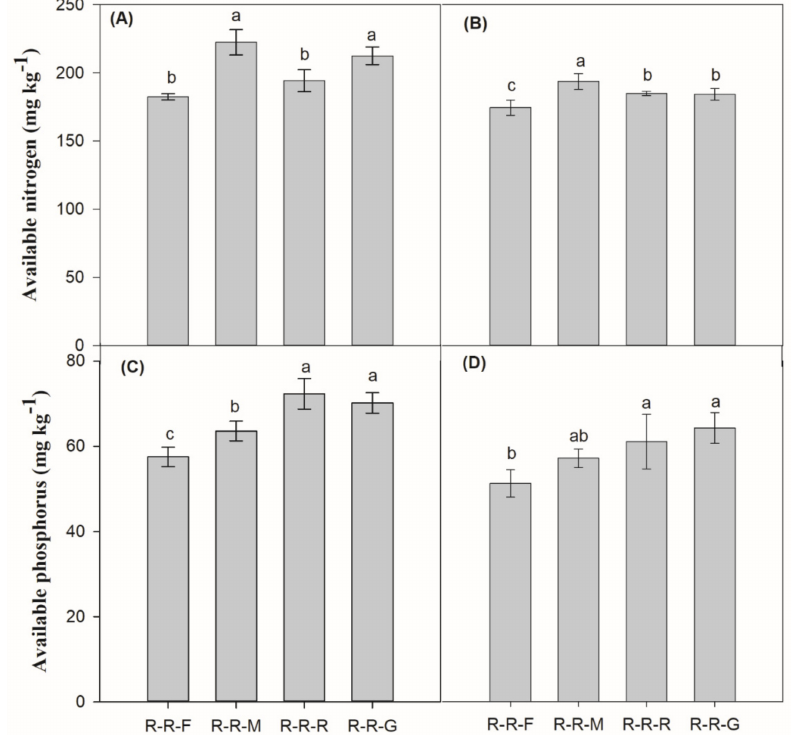
Figure 2. E ff ect of di ff erent long-term green manure rotations on soil available N after early rice harvest ( A ) and after late rice harvest ( B ), and available P after early rice harvest ( C ) and after late rice harvest ( D ). Error bars represent ± standard deviations; di ff erent letters over the bars indicate significant ( p ≤ 0.05) di ff erences according to Tukey’s LSD